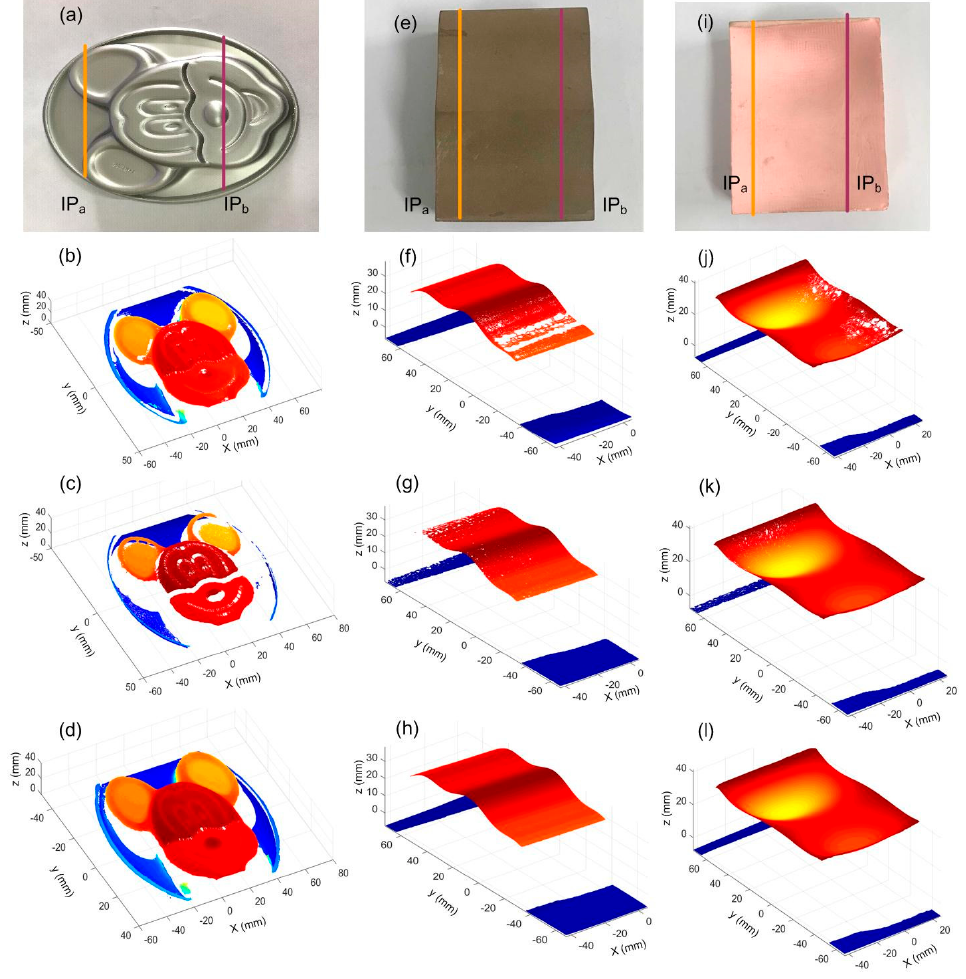
Figure 15. Measurement results of the parts at different exposure times. ( a , e , i ) The parts under inspection; ( b , f , j ) at a constant exposure time of T a ; ( c , g , k ) at a constant exposure time of T b ; ( d , h , l ) at adaptively controlled exposure time.